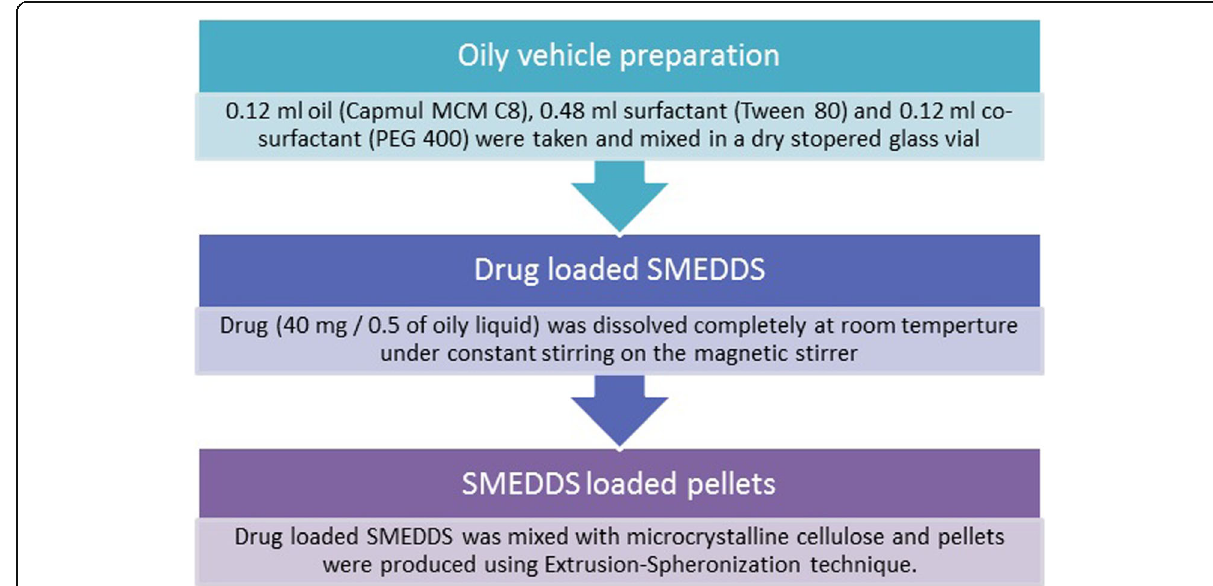
Fig. 3 Schematic flow for preparation of gliclazide SMEDDS